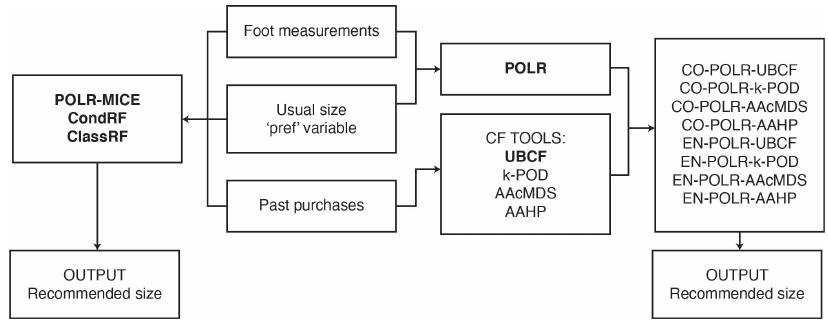
Figure 1. Overview of the recommendation system framework. Experimental